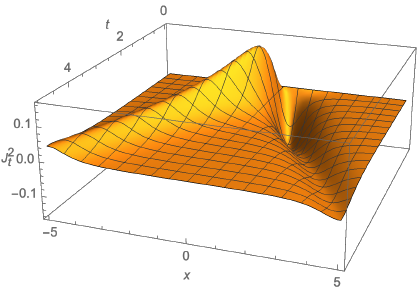
as a function of ( t, x ) for t = 1 and e = 1 and we use H